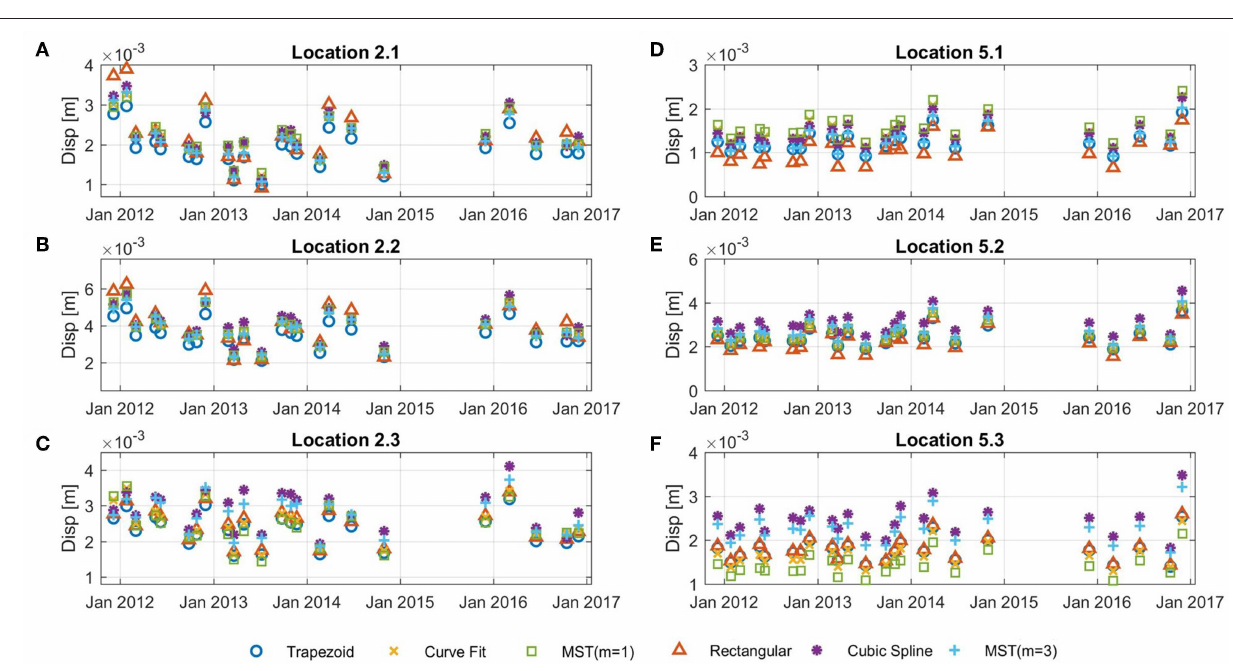
Frontiers in Built Environment |